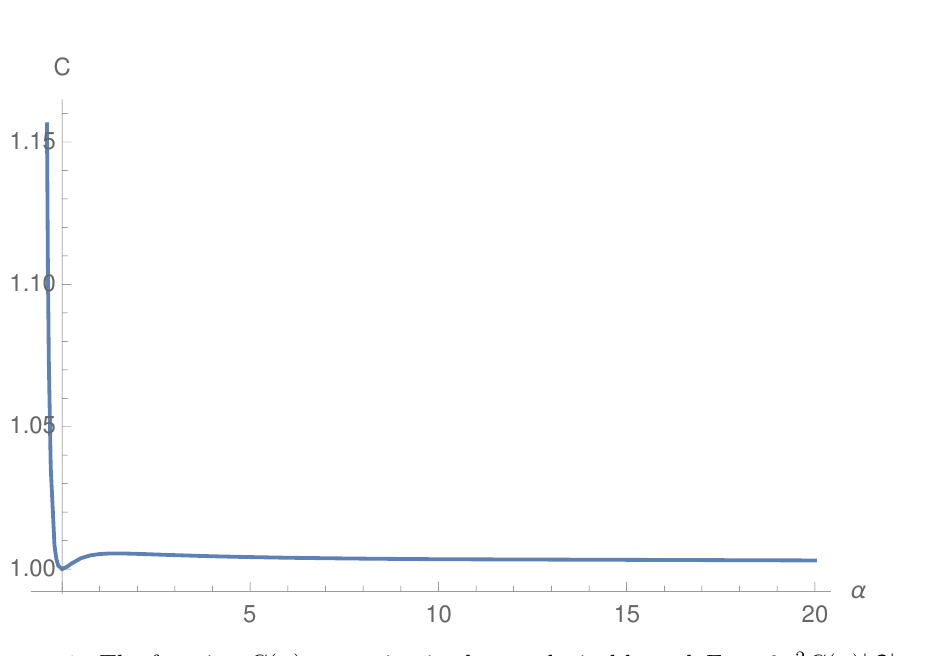
Figure 1. The function C ( (cid:11) ) appearing in the topological bound E (cid:11) (cid:21) 8 (cid:25) 2 C ( (cid:11) ) jQj